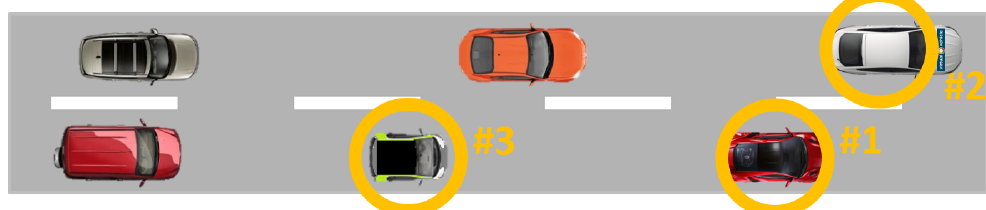
Figure 12. M86 Test Scenario 4 with the ego-vehicle in the lead